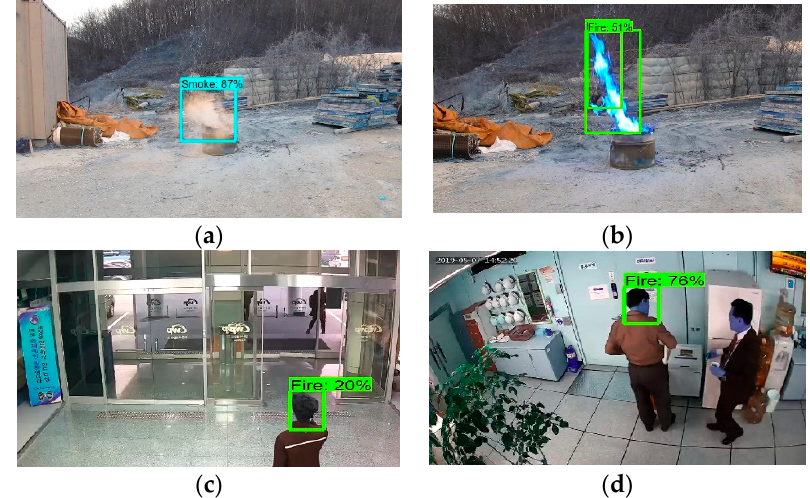
Figure 5. The result of coefficient variation values for detected area, ( a ) smoke area Coefficient of Variation (CV) value: 1.5 (87%), ( b ) fire area CV value: 1.9 (51%), ( c ) false alarm area CV value: 6.2 (20%), and ( d ) false alarm area CV value: 13.6 (76%).